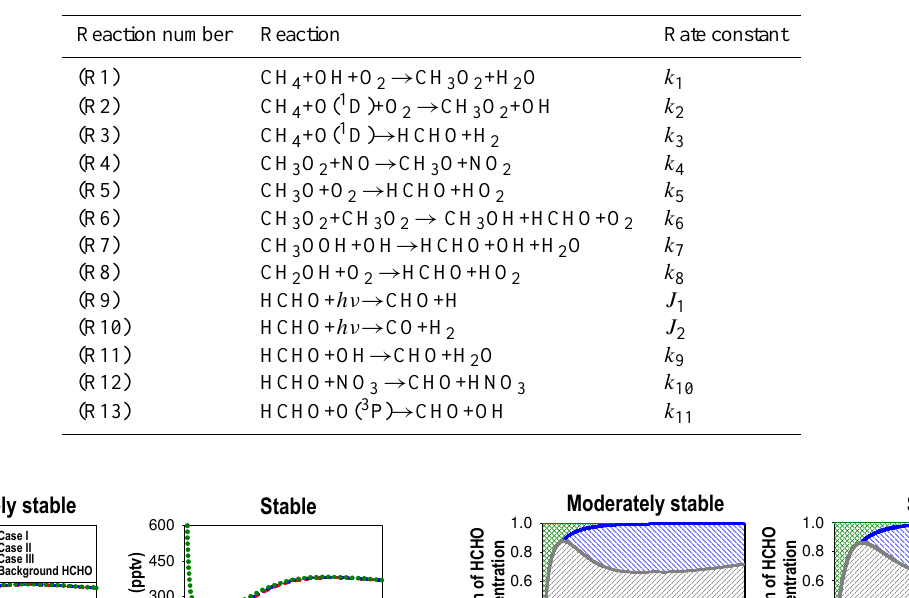
Table 3. Some reactions related to HCHO photochemistry in the MBL.